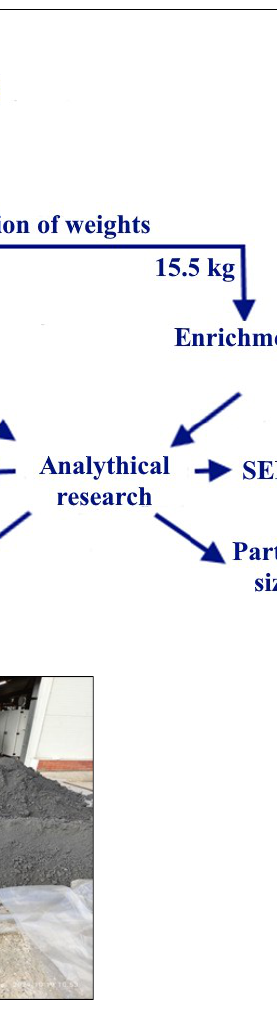
Figure 7. Ferromagnetic grinding media ( a ) and resulting powder ( b ).